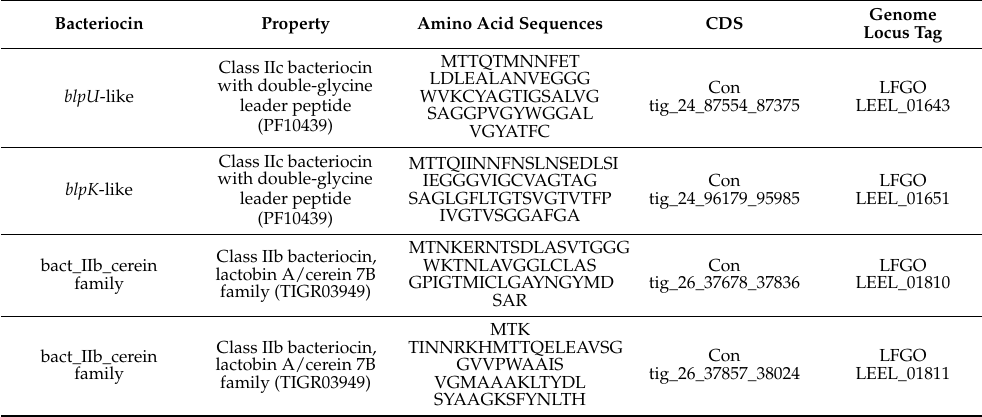
Table 2. Bacteriocins detected in the S. salivarius 24SMBc genome: property, amino acid sequence, and their localization in the